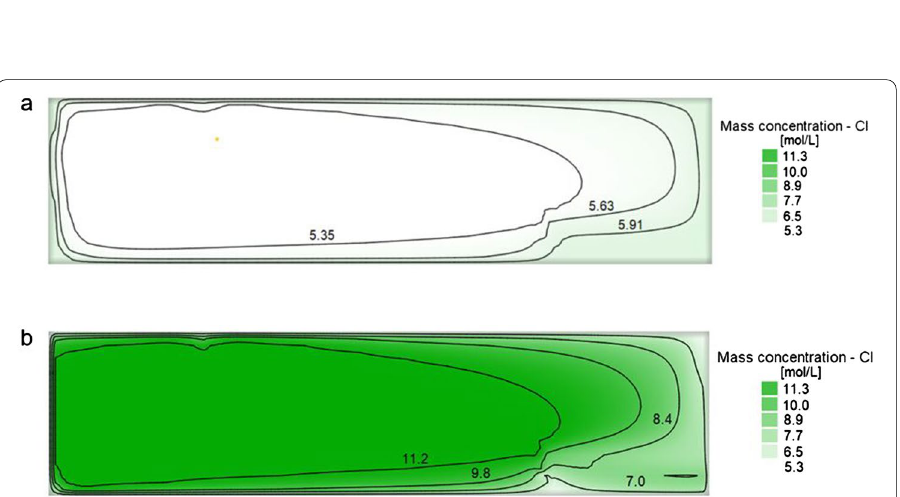
Fig. 5 Geothermal doublet aqueous ion concentration after 365 days for a NaCl brine heat exchange fluid, saturated at 10 °C ( a ), and an MgCl 2 brine heat exchange fluid, saturated at 10 °C ( b ) injected into a halite formation at 70